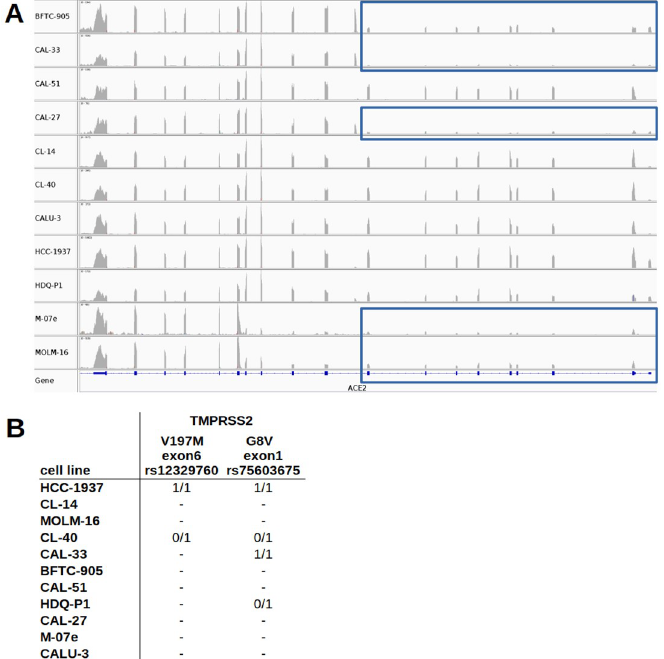
Fig 4. ACE2 and TMPRSS2 transcript variants for the cell lines. A: Different exon usage of ACE2 for the top 10 ACE2 expressing cell lines plus CALU-3 (see S2 Fig for the top 25 cells). BFTC-905, CAL-33, CAL-27, M-07e, and MOLM-16 show reduced exon expression from exon 1–9 (blue rectangles). Cell lines are ordered alphabetically. ACE2 is reversely oriented. B: Missense variants in the coding regions of TMPRSS2 (V197M = rs12329760, G6V = rs75603675) for the selected cell lines. No mutations were found in the coding regions of ACE2 . 0/1 denotes heterozygous and 1/1 homozygous